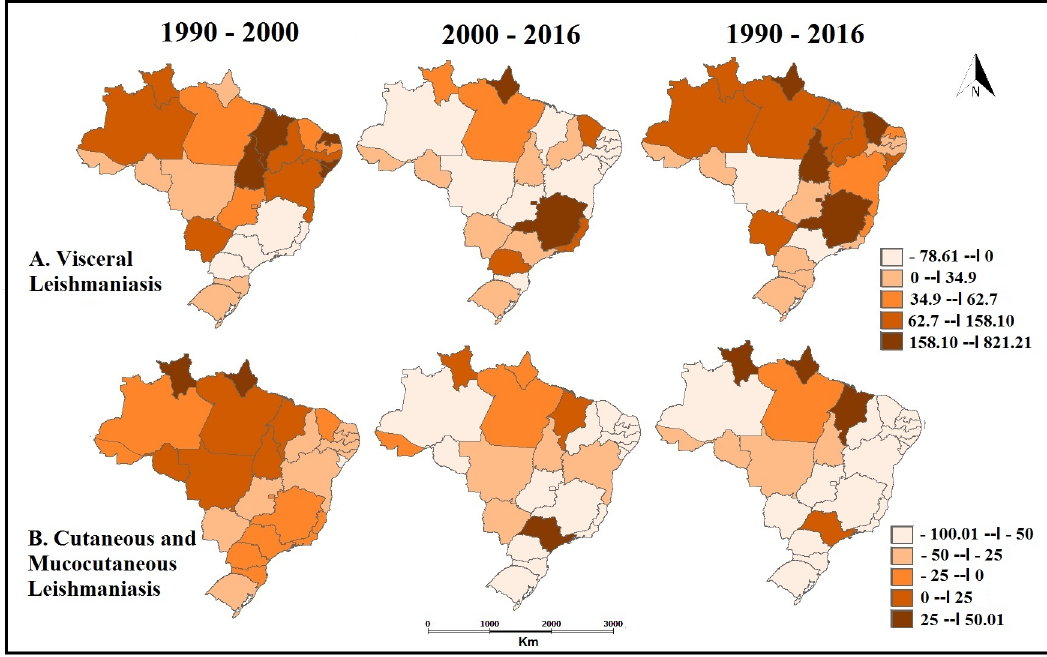
Fig 5. Percentages of change calculated for years of life lost (YLL) for Visceral Leishmaniasis (A) and years of life lost (YLD) for Cutaneous and Mucocutaneous Leishmaniasis (B) per 100,000 inhabitants from 1990to 2016 considering Brazil’s federated units. GBD Study